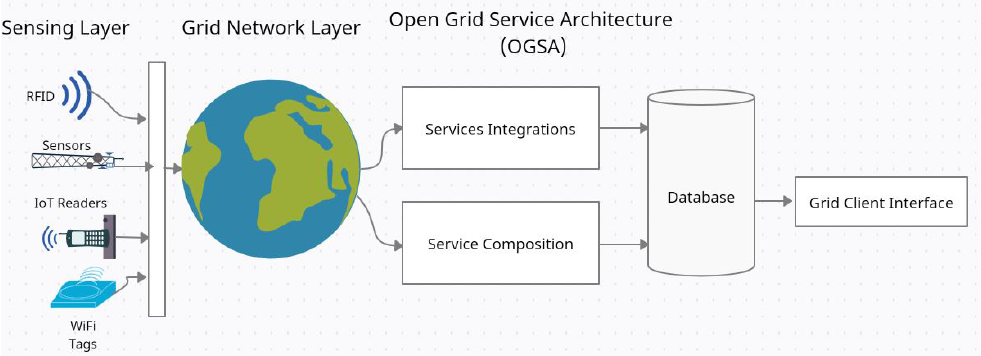
Figure 1. IoT Grid